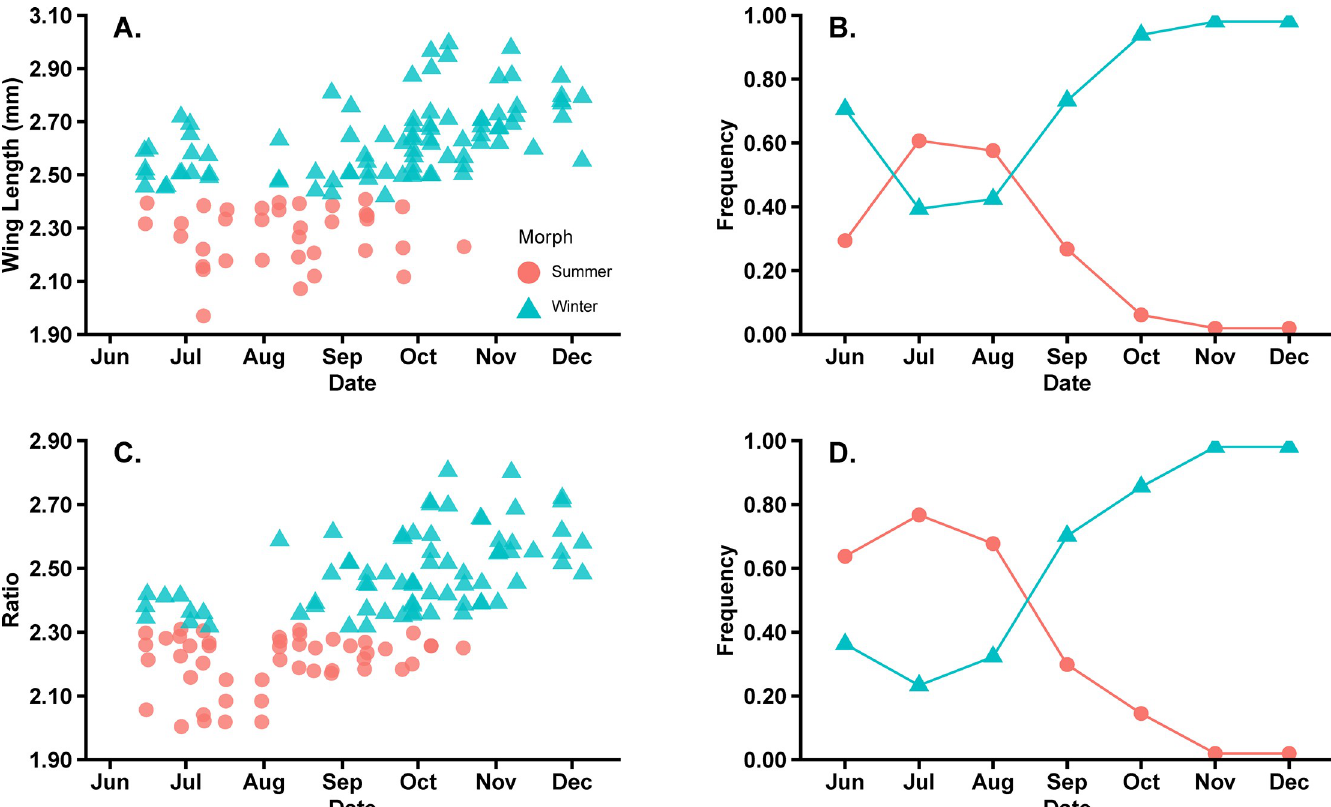
Fig 6. Predicted phenology of field caught male D . suzukii . Total of male D . suzukii morphs trapped from 2017–2018 (A and C) and the frequency (B and D) based on wing length (A and B) and transformed ratio of wing length to hind tibia length (C and D).